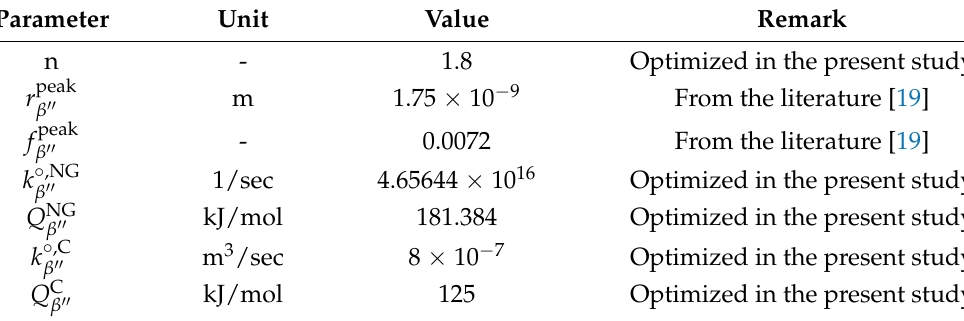
Table 2. Model parameters for the precipitation kinetics of β (cid:48)(cid:48) .